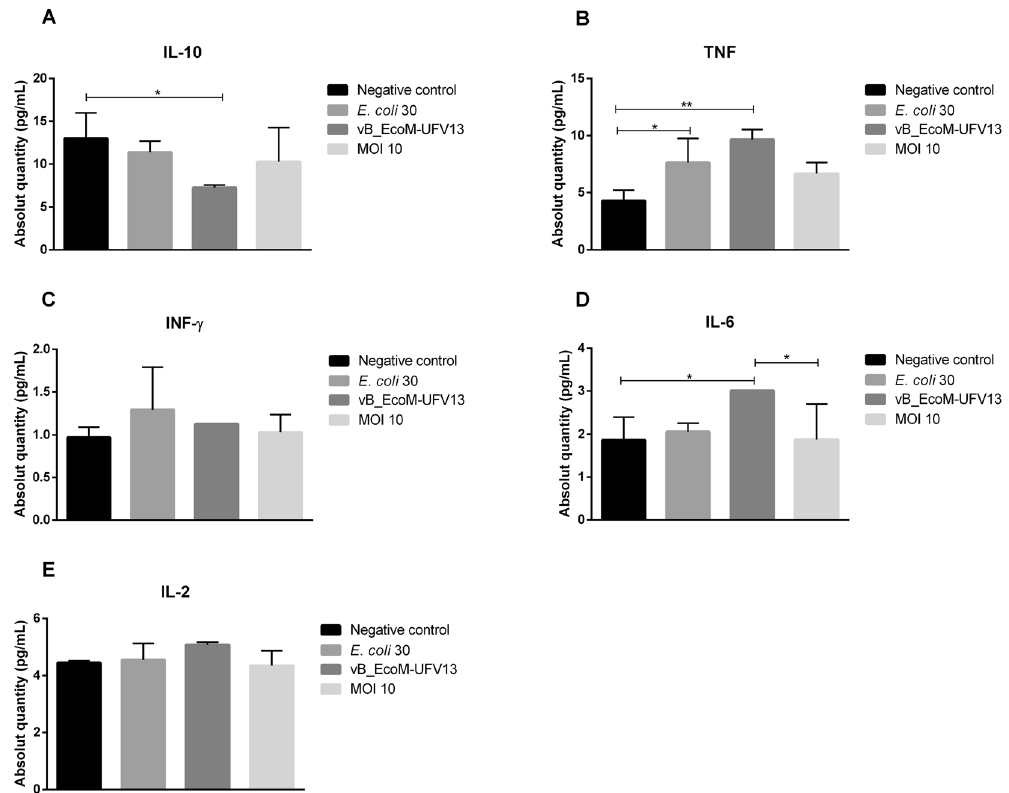
Figure 6. Five different cytokines (IL-6, TNF- α , IL-2, IFN- γ and IL-10) were locally measured. Only IL-10, TNF- α and IL-6 were statistically significant ( * p < 0.05; ** p < 0.01) and is indicative of a pro-inflammatory pattern after phage treatment. IL-17A and IL-4 levels were not detected by the Cytometric Bead Array